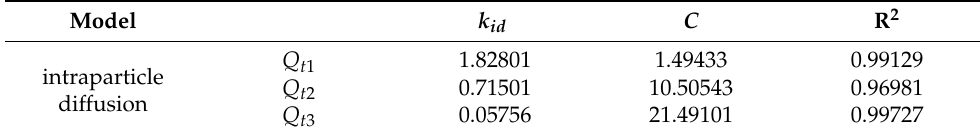
Table 2. Parameters of intraparticle diffusion model fitting for adsorption of NB by cellulose-St.